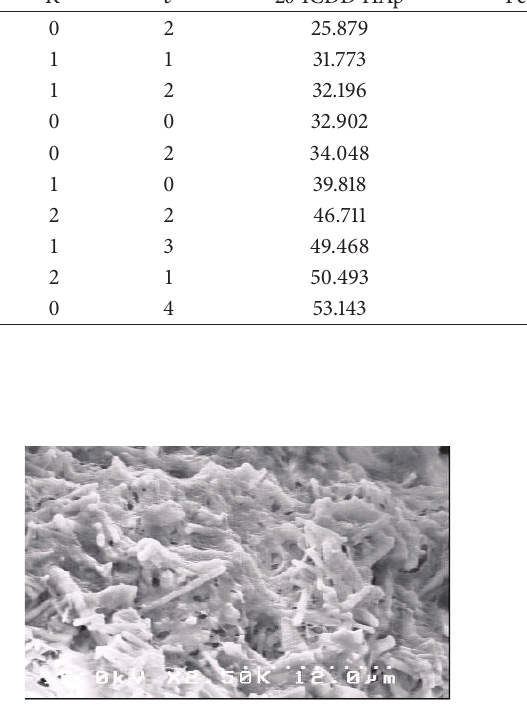
Figure 4: SEM micrograph of the matrix of copolymer with dispersed phase of hydroxyapatite needle-shaped particles.